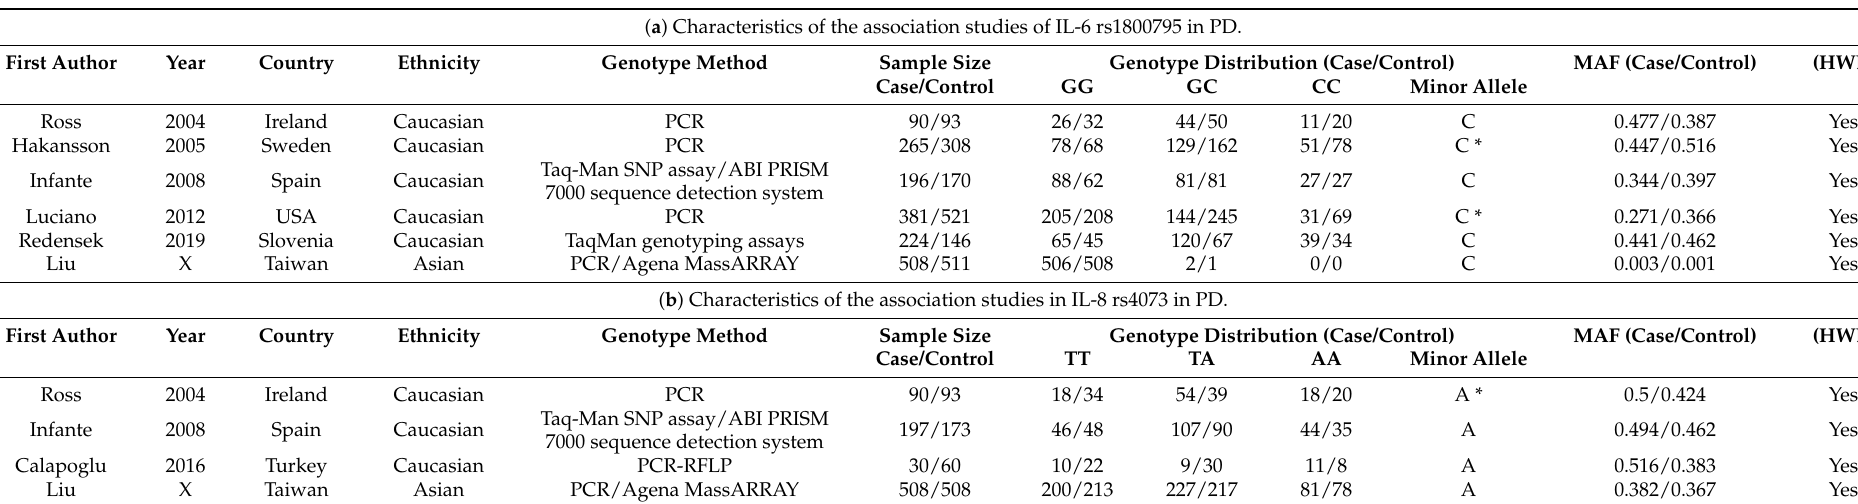
Table 3. Characteristics of the association studies of IL-6 rs1800795 and IL-8 rs4073 in PD. ( a ) Characteristics of the association studies of IL-6 rs1800795 in PD.